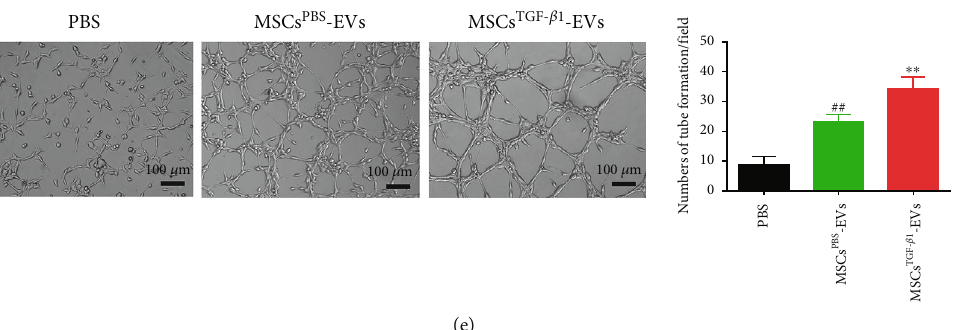
Figure 4: MSC TGF- β 1 -EVs induce HUVEC proliferation, migration, and tube formation in vitro . (a) Cell proliferation of HUVECs after administration of PBS, MSC TGF- β 1 -EVs, and MSC PBS -EVs as measured by CCK-8 assay, n = 3 . (b) Cell proliferation of HUVECs measured by EdU staining, n = 3 . (c) Representative images showing migrated HUVECs using the Transwell assay (left). Quantitative analysis of the migrated cells (right), n = 3 . (d) Representative images showing the migration ability of HUVECs at 24h using a wound healing assay (left). Quantitative analysis of the migration rate of HUVECs (right), n = 3 . (e) Representative images showing tube formation in HUVECs treated with PBS, MSC TGF- β 1 -EVs, and MSC PBS -EVs (left). Quantitative analysis of the tube formation assay (right), n = 3 . Data are expressed as mean ± SD . # P < 0 : 05 and ## P < 0 : 01 , PBS vs. MSCs PBS − EVs < 0 : 05 ; ∗∗ P < 0 : 01 , MSC PBS -EVs vs. MSC TGF- β 1 -EVs. MSCs: mesenchymal stem cells; EVs: extracellular vesicles; HUVECs: human umbilical vein endothelial